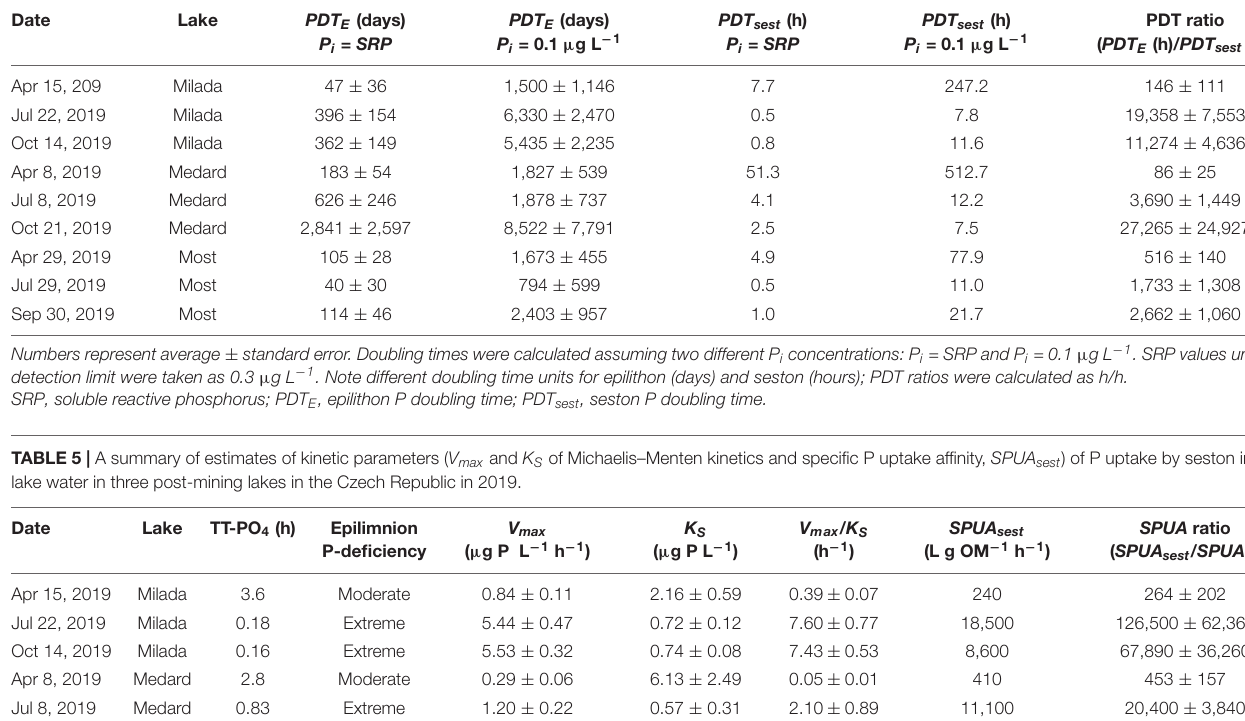
TABLE 4 | A summary of estimates of phosphorus doubling times in epilithon ( PDT E ) and seston ( PDT sest ) in three post-mining lakes in the Czech Republic in 2019.